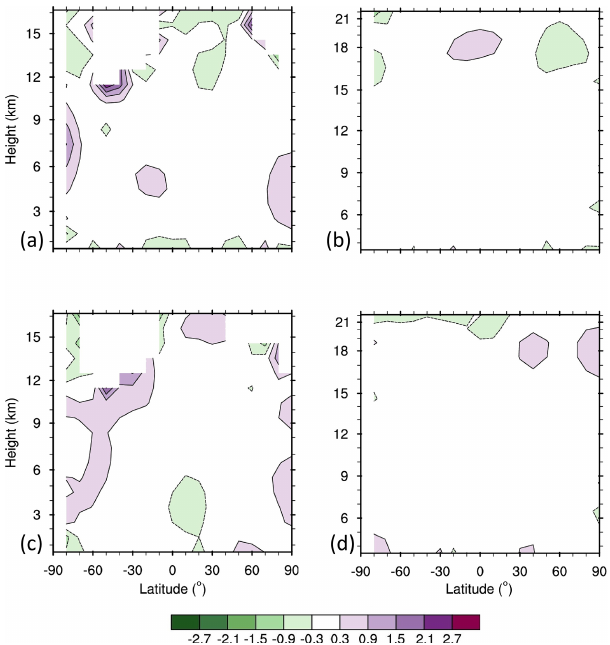
Figure 15. As in Fig. 3 but after the TLS bias correction is